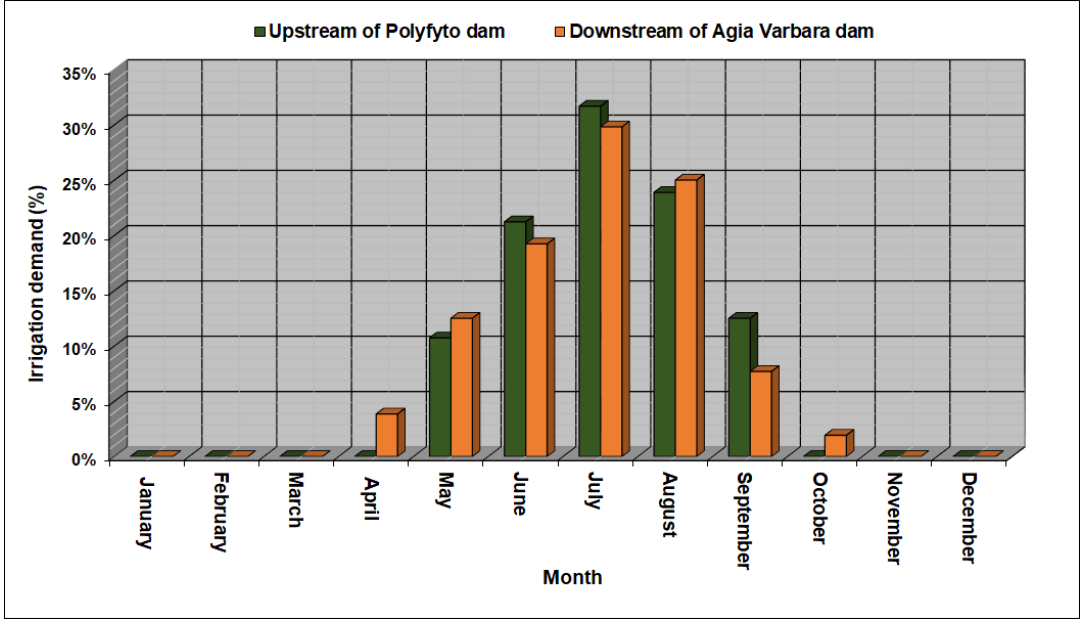
Figure 5. The monthly distribution of demand for irrigation from Polyfyto and Ilarion reservoirs.